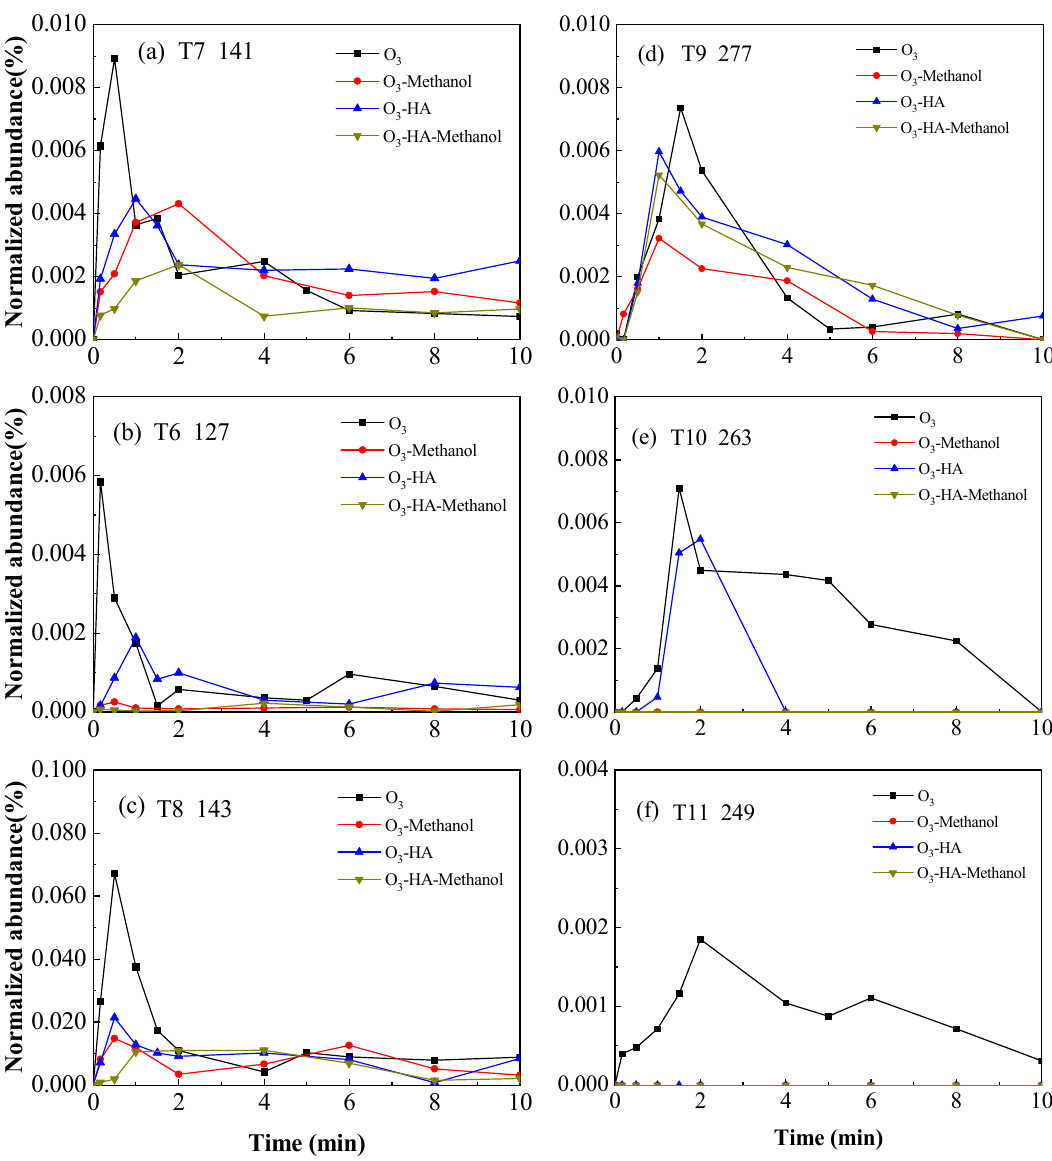
Figure 4. Formation of cleavage (a–c) and demethylation (d–f) products during TMP ozonation (initial TMP concentration = 10 mg/L, initial pH = 6.0 ± 0.1, 20 °C).